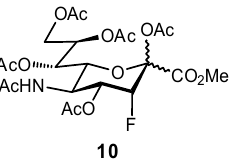
Figure 4. A Neu5Ac-based glycomimetic 10 was successful in preventing tumor metastasis in a mouse model [50] .